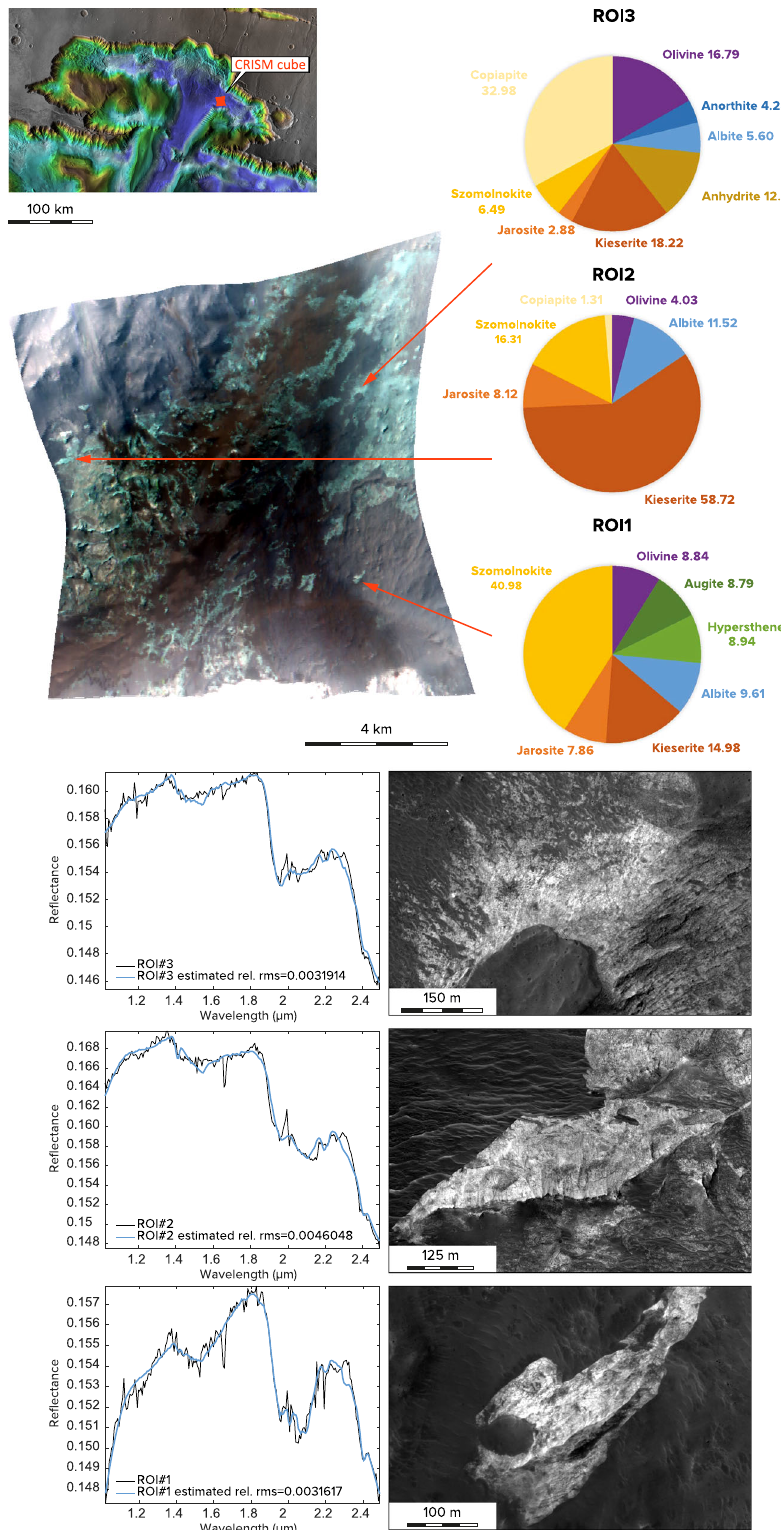
Fig. 2 Results of nonlinear spectral unmixing applied to the three selected regions of interest (ROI). Location of the three ROIs on CRISM image FRT00018b55 (bands R: 233, G: 78, B: 13), mineral relative abundances, the best fi t plots with the relative RMS indicated, and corresponding HiRISE images of ROI1 (ESP_051999_1755_RED), ROI2 (ESP_039525_1755_RED), and ROI3 (ESP_039525_1755_COLOR). The result of a mixture containing pure albite and anorthite (ROI3) is interpreted as a plagioclase (albite-anorthite) solid solution. The same stands for the kieserite-szomolnokite solid solution. Credits: CRISM data: NASA/Johns Hopkins University Applied Physics Laboratory; HiRISE images: NASA/JPL/the University of Arizona. The background of the location map is THEMIS Day IR Global Mosaic 92 merged with the 128 ppd MOLA digital terrain model 93 .